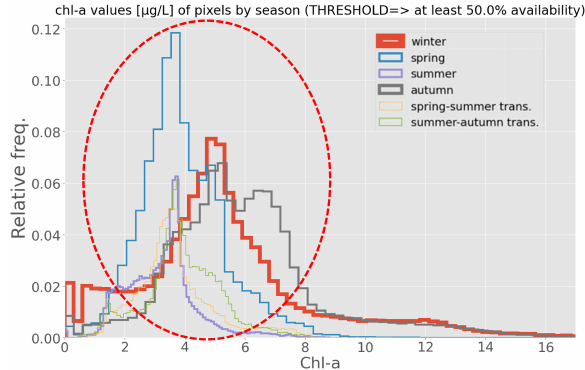
Figure 8. Histograms per season- Chlorophyll-a (three lakes).